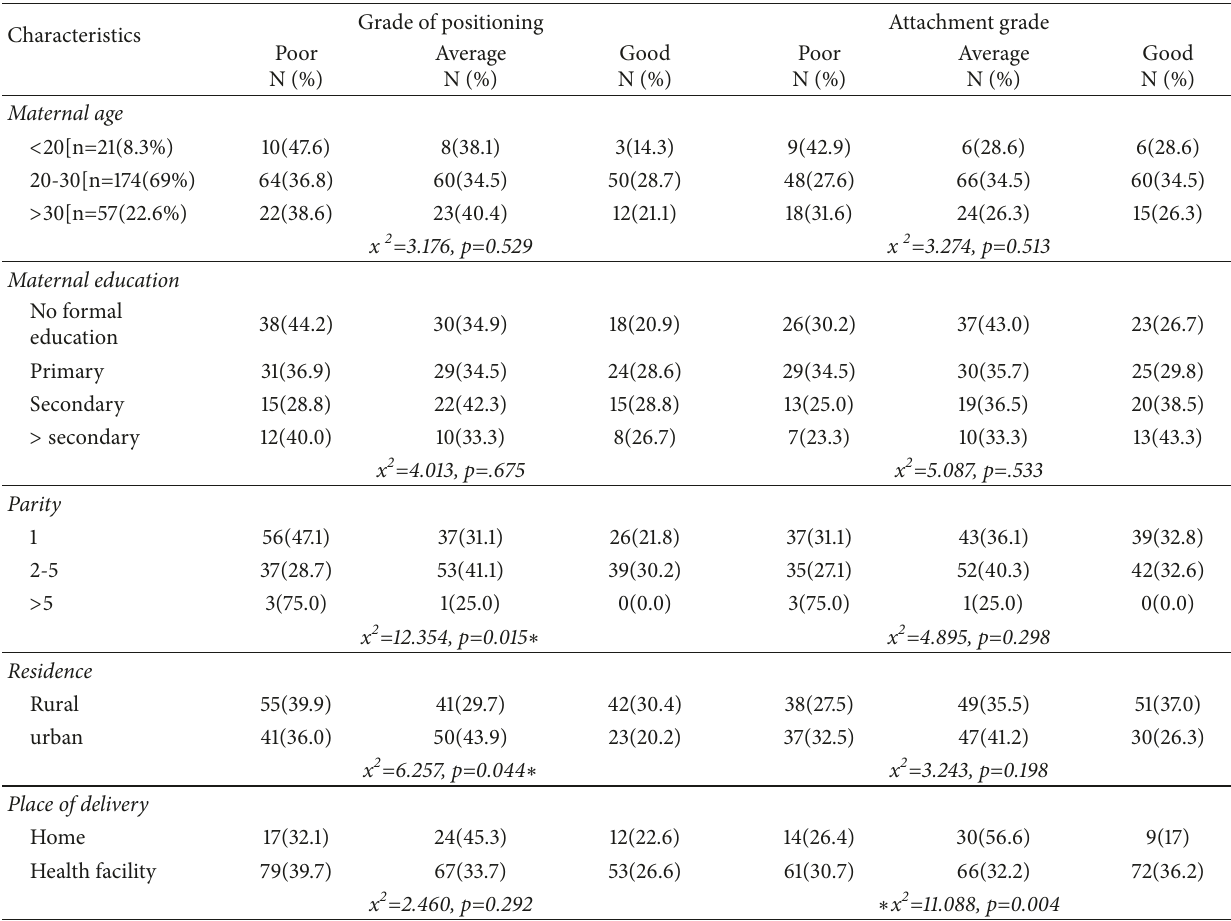
Table2:Cross-tabulationofmaternalcharacteristicsandpositionofmotherandinfantandattachment(latch-on)tothebreastduringfeeding among mothers visiting health facilities in Areka town, Southern Ethiopia, 2017.